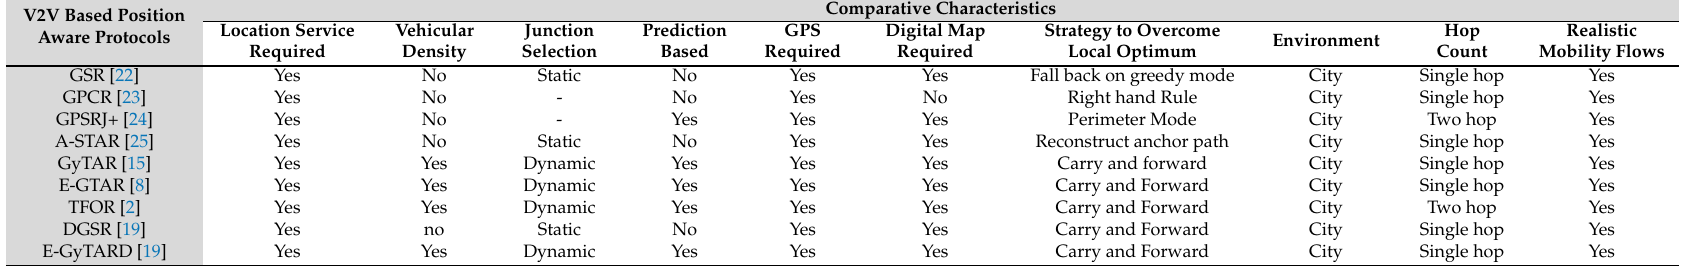
Table 2. Comparative study of position aware routing protocols for urban